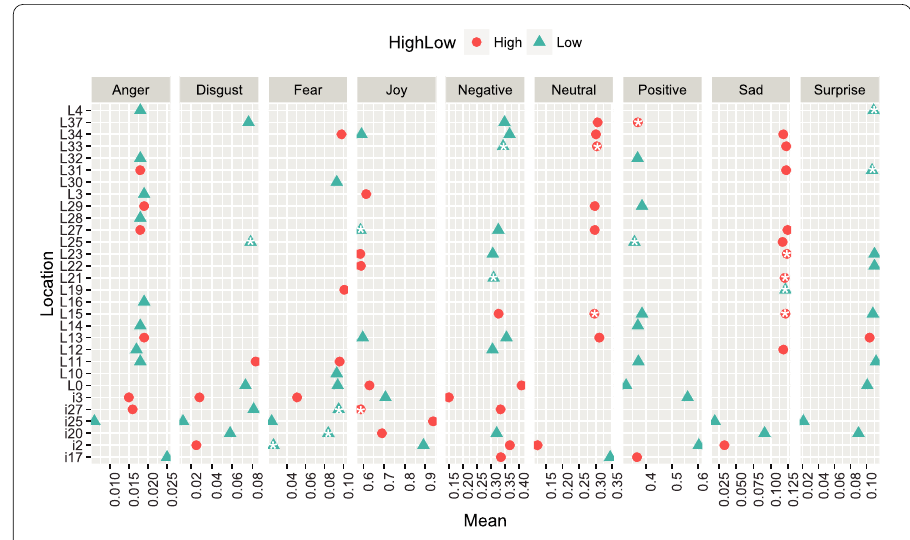
Figure 7 Emotion and sentiment differences in high vs. low ILI seasons across 31 military locations. We report the highest mean numbers (either the mean during high or low season) when the differences between high vs. low affect distributions are statistically significant with ( p -value ≤ 0.05) for 31 locations.